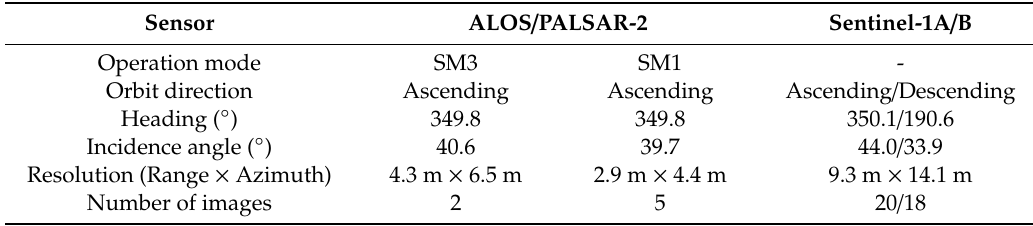
Table 1. The parameters of synthetic aperture radar (SAR) satellite